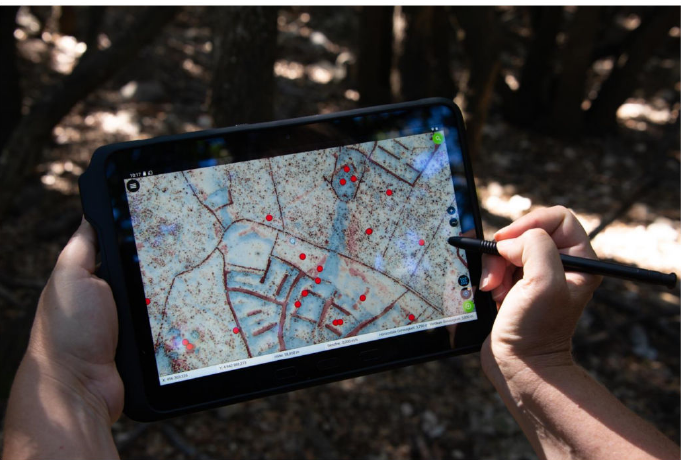
Figure 9. The tablet device in the field. QField was used to view and edit GIS layers in the field, with the current GPS position visible on the screen (the small white dot in the centre of the tablet). (Photo: M. Doneus, 1 September